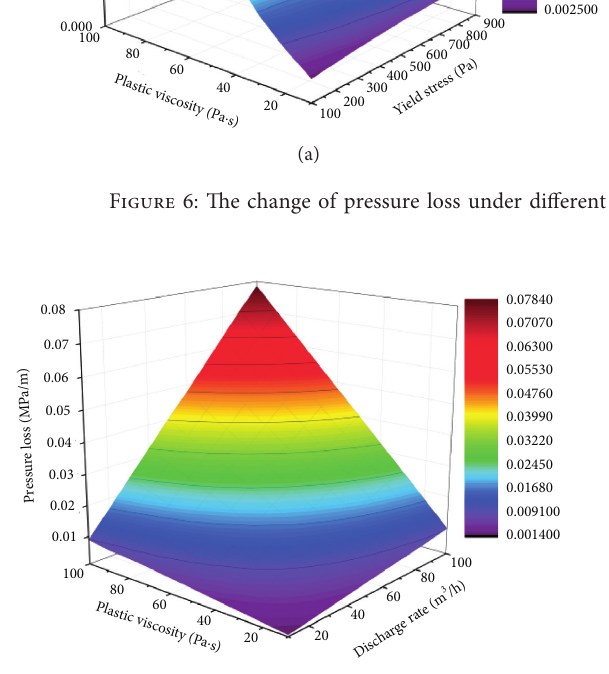
Figure 7: The pressure loss change under different discharge and plastic